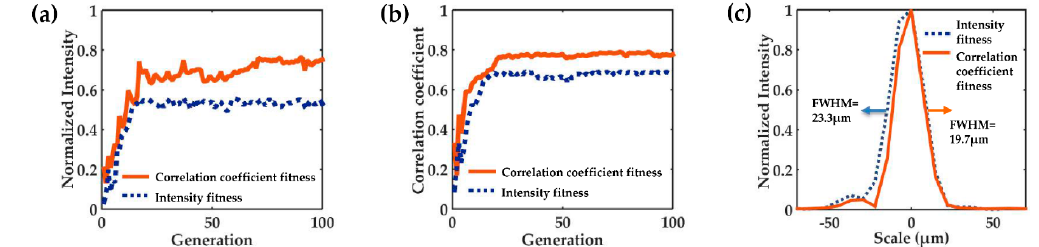
Table 1. Comparison of optimization abilities under three methods.